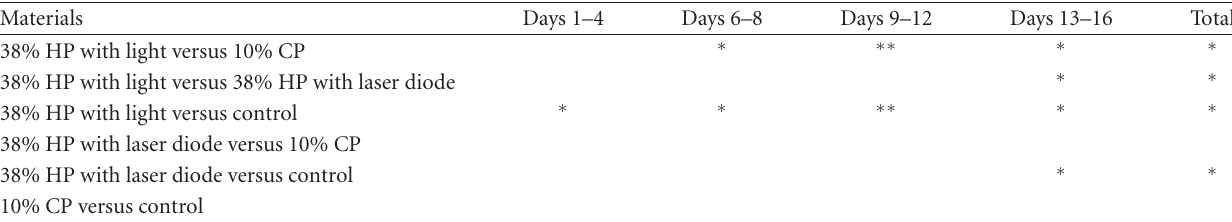
Table 2: Statistical di ff erences of the test groups in the end of 4th, 8th, 12th, and 16th